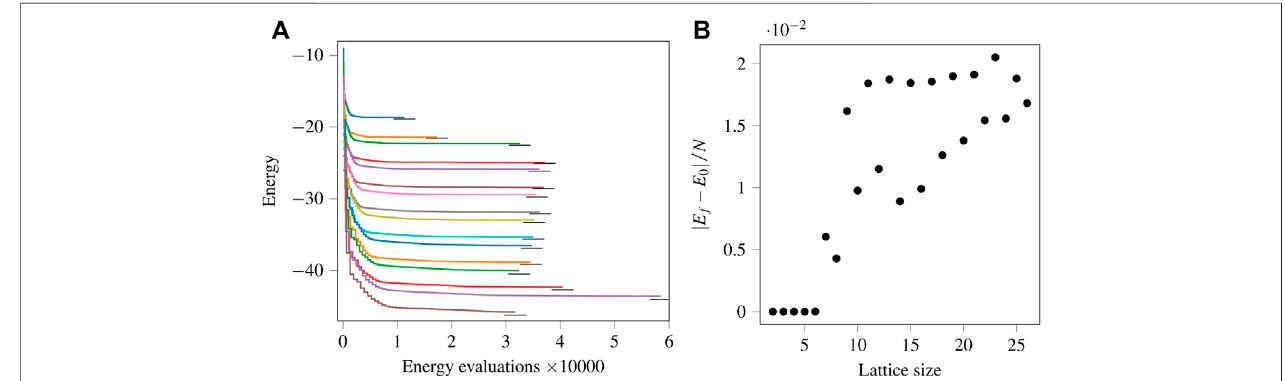
FIGURE3| (Colour online) (A) : Optimization progress using theXYansatzfor11spins ( fi rstline), 12spins (second line) and soon, upto26spins(bottom line). The smallhorizontalblacklinesrepresentthegroundstateenergy. (B) :Absolutedifferenceinthevariationalandgroundstateenergyperspinfordifferentspinsorlatticesize.